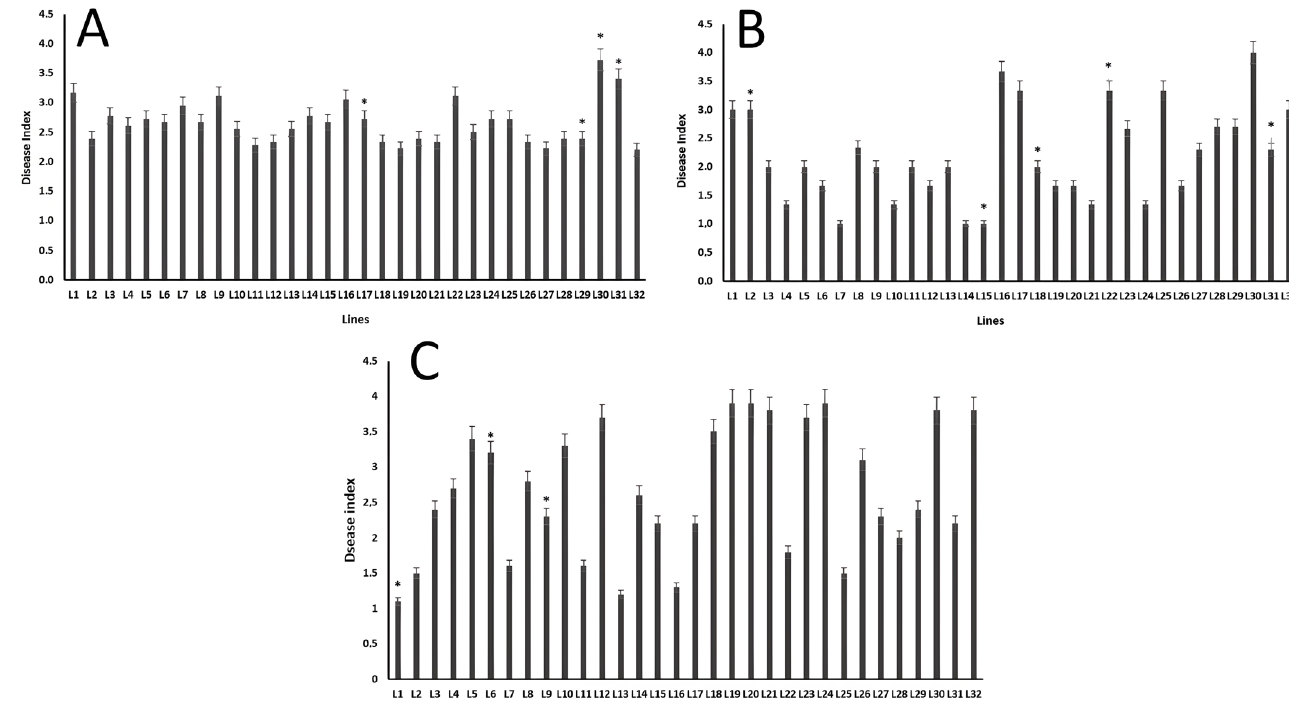
Figure 1. Crown rot disease index of 32 spring wheat lines (including 6 check lines) to Fusarium culmorum . ( A ) Disease index in field conditions of three locations (Eski¸sehir, Yozgat, and Konya). ( B ) Greenhouse conditions in Eski¸sehir. ( C ) Growth room conditions in Eski¸sehir. Asterisks (*) represent homogeneous groups based on the protected least significant difference test for each variable at p < 0.001. Error lines on bars represent the standard error (n = 6).